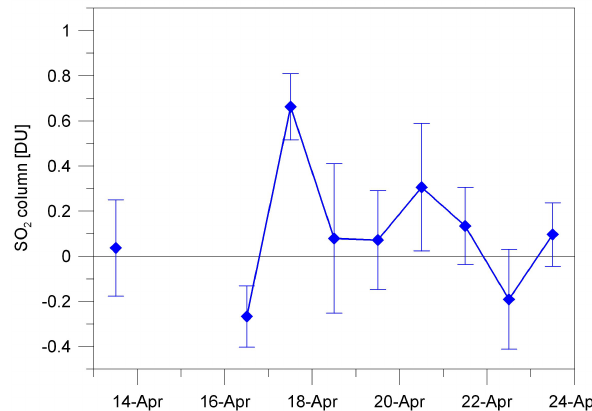
Fig. 8. SO 2 column measurements (daily means) by the Hohenpeis- senberg Brewer spectrometer. Maximum column densities of about 0.7DU were measured on 17 April (corresponding to a 3km layer with 3ppb SO 2